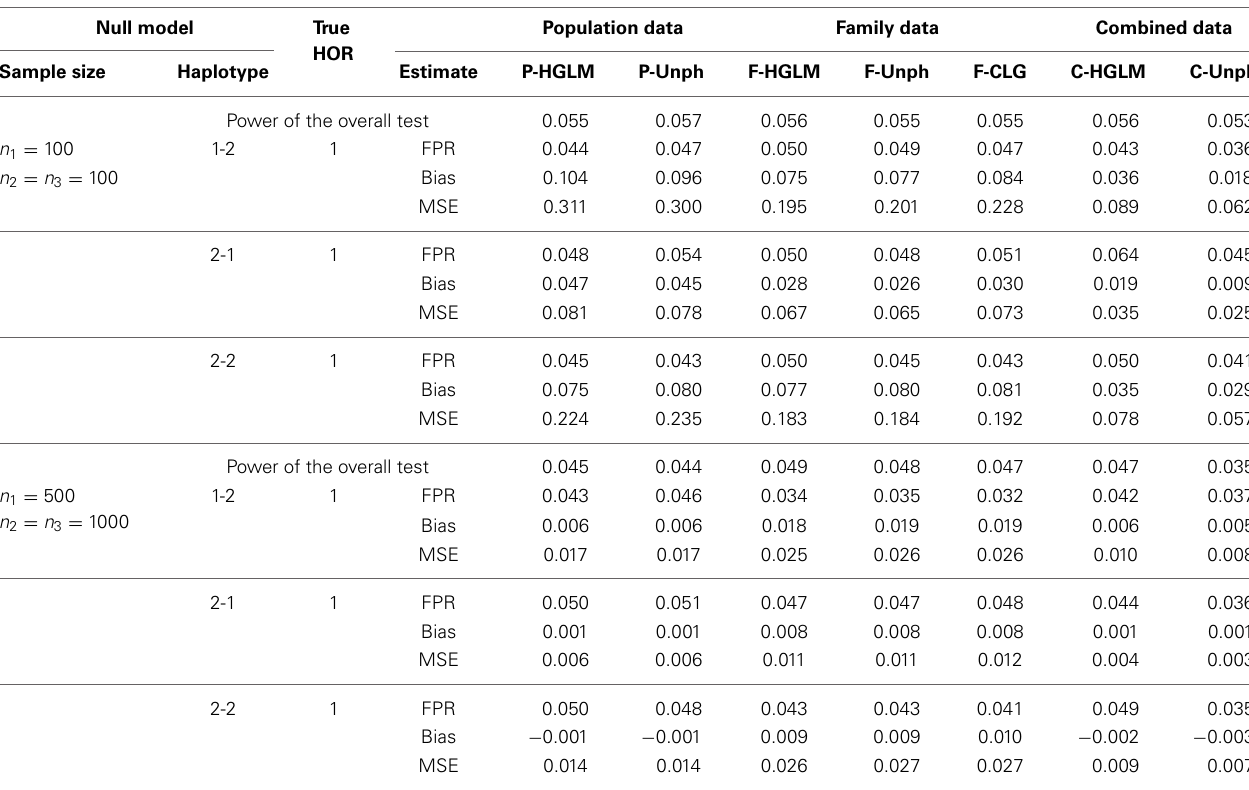
Table 1 | False positive rate under all haplotype odds ratios (HOR) equal to